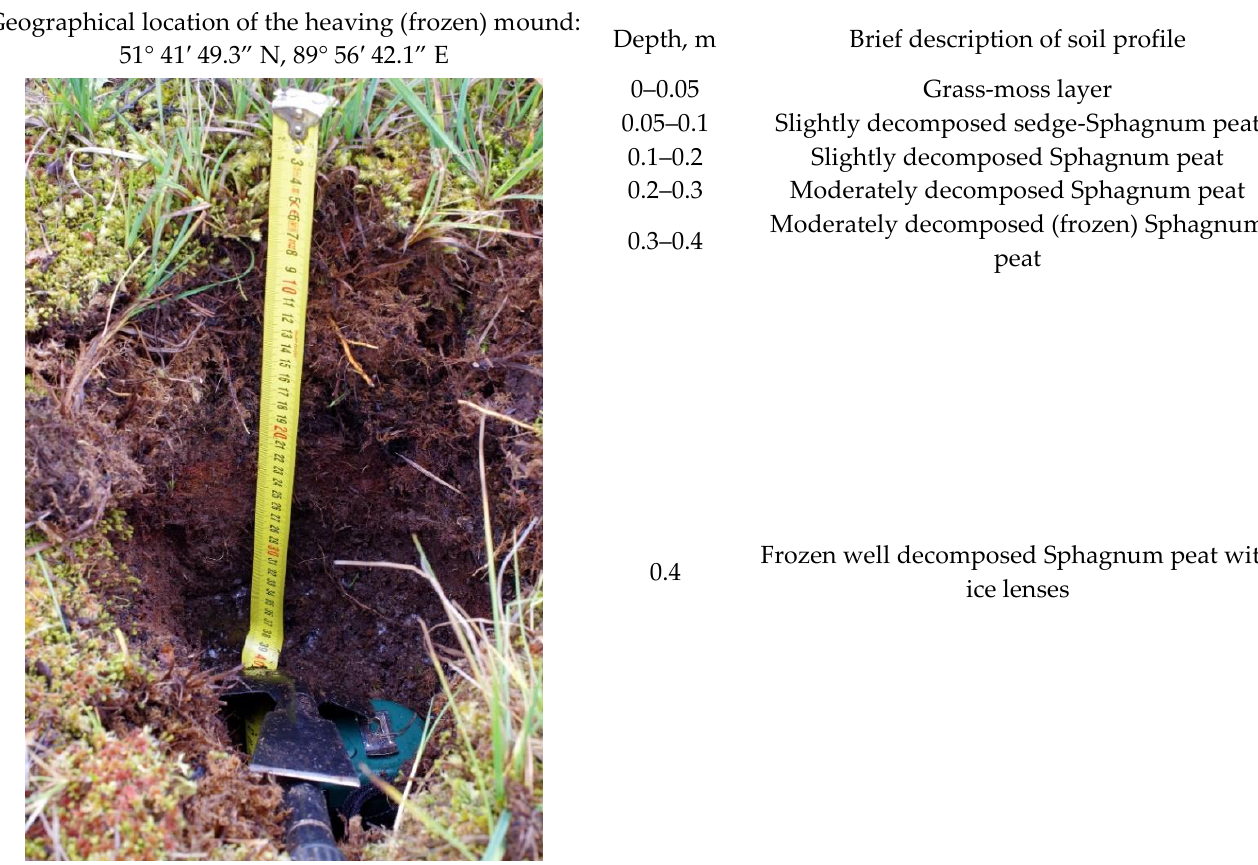
Figure 10. Flow (water) channel at the Adyr-Khem key site (photo by Volkov, 2021). On the slope, a forest belt is formed, which has two thermal boundaries —the “classical” upper forest line and the lower boundary associated with the sinking of cold air to the bottom of the Adyr-Khem valley.